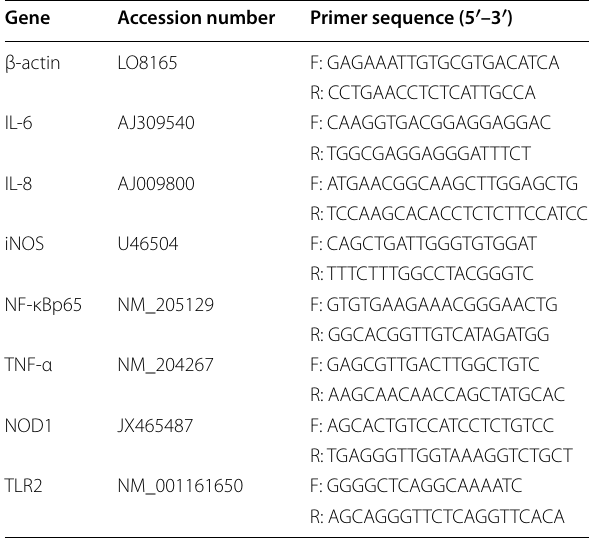
Table 2 Primer sequences of some genes for